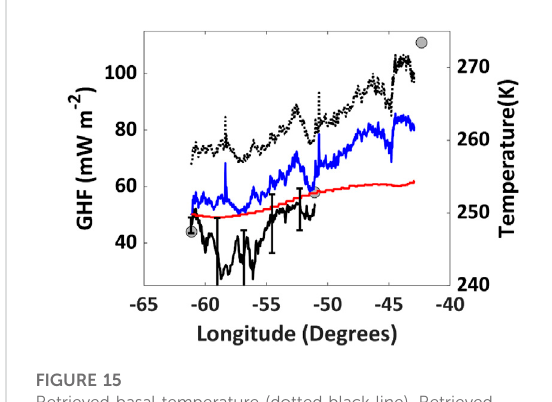
FIGURE 16 Thickness and salinity retrieved using the RT model lookup table(thick dashed line). Thickness and salinity curves were smoothed using a16-point moving average. Thin solid line in